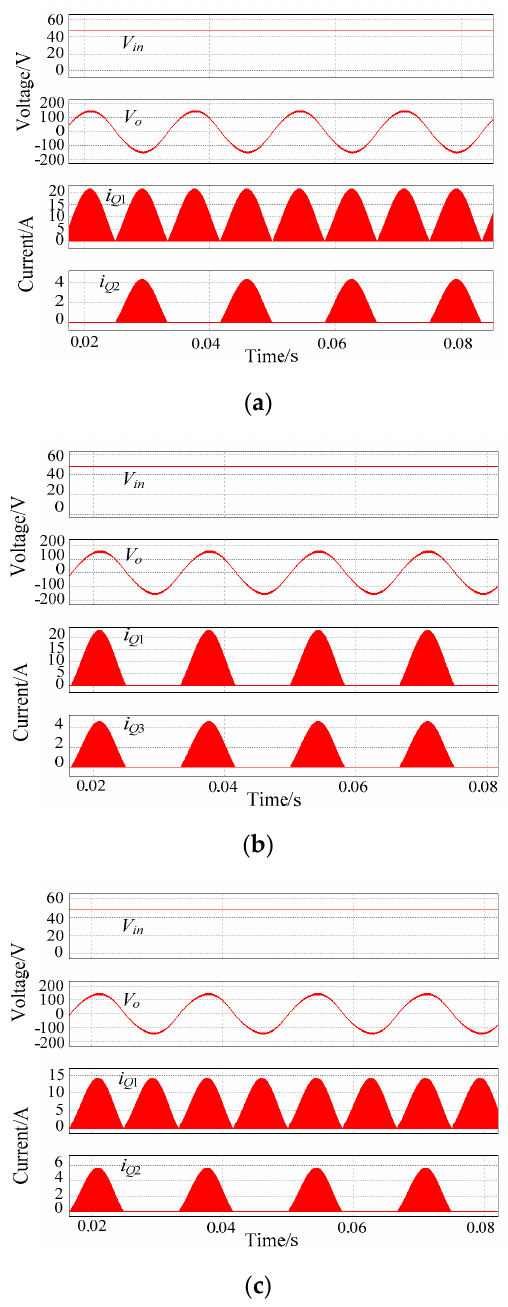
Figure 8. Simulation waveforms of the input voltage, output voltage, and switches’ current of the variant topologies: ( a ) Figure 3a, ( b ) Figure 3b, ( c ) Figure